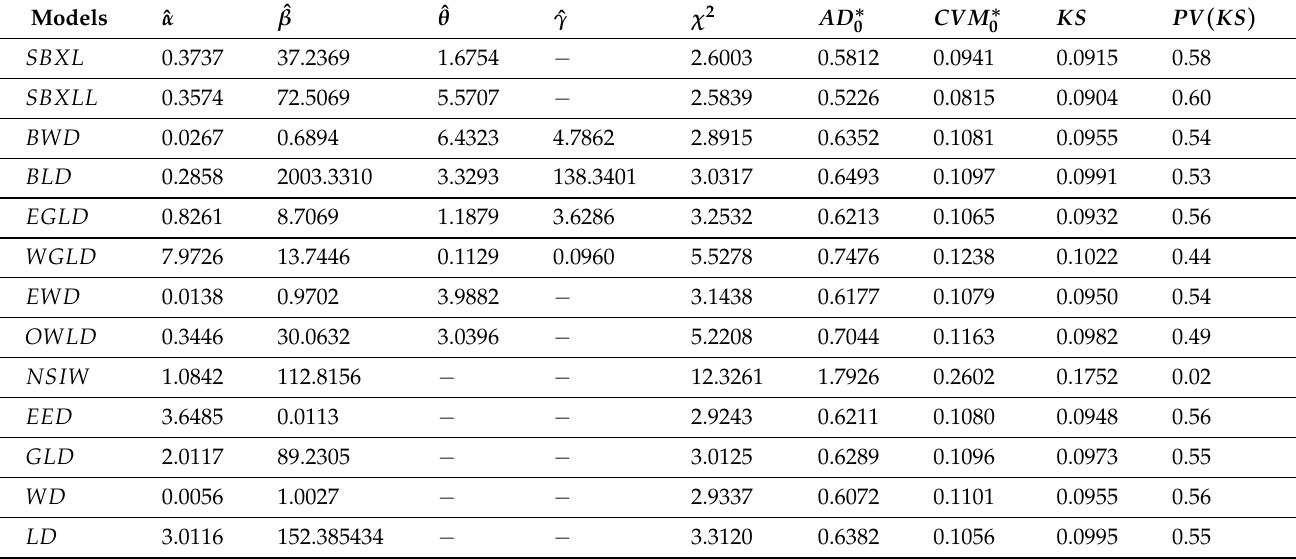
Table 27. MLEs and goodness-of-fit related to data set-V for SBXL and SBXLL models.